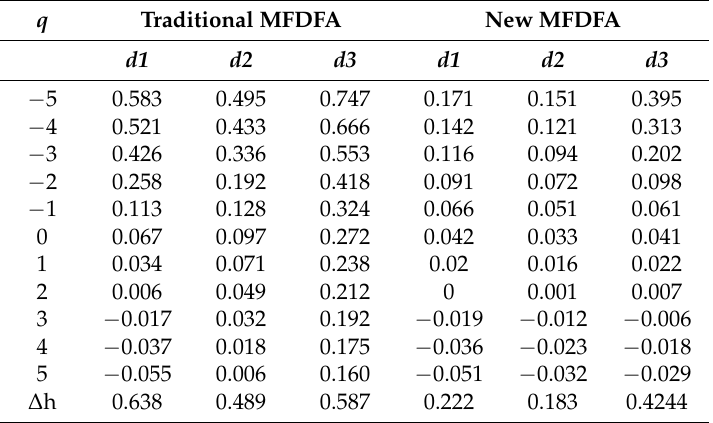
Table 3. h(q) values of the harmonic signal computed analytically through MFDFA and the new